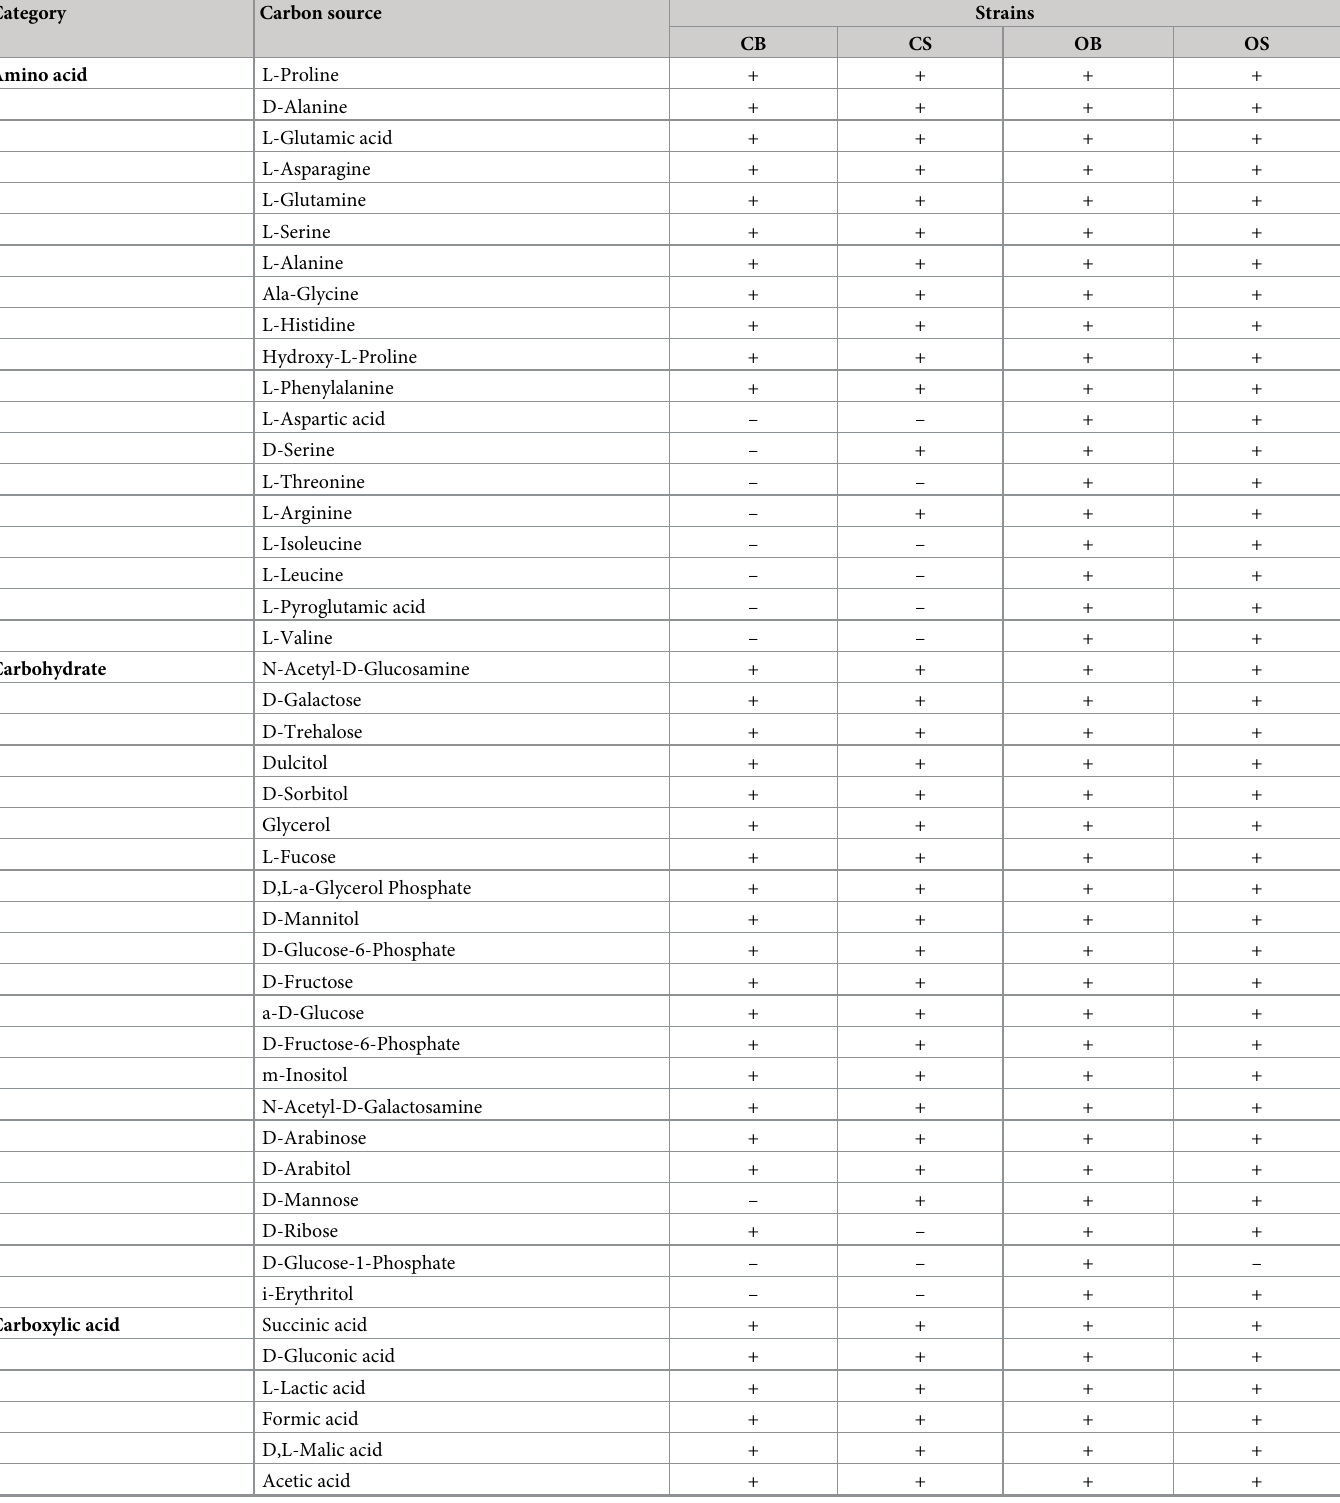
Table 6. Summary of phenotype microarray results. Category